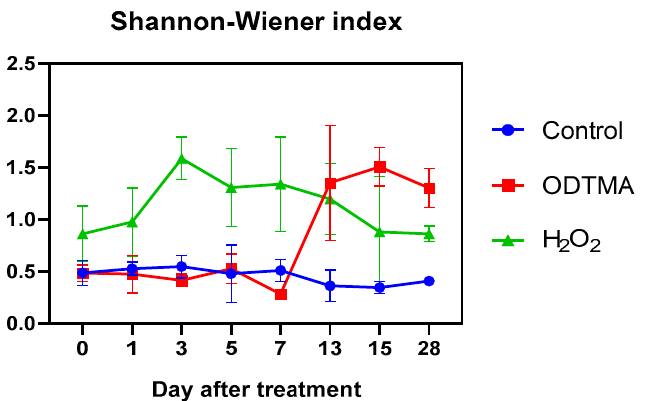
Figure 7. Species diversity indices (Shannon–Wiener) for ODTMA-Br (C18) and H 2 O 2 treatment in the mesocosm experiment.